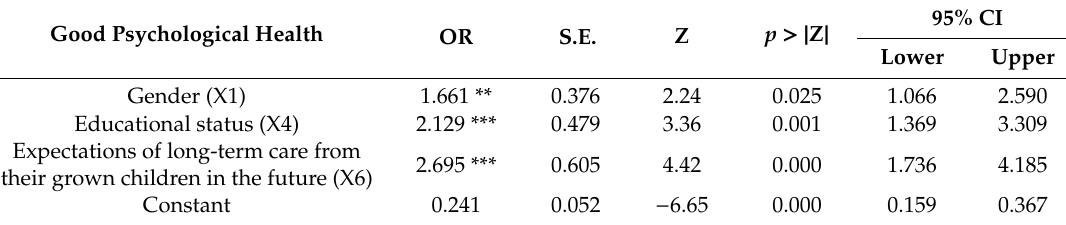
Table 5. Logistic regression results in the last